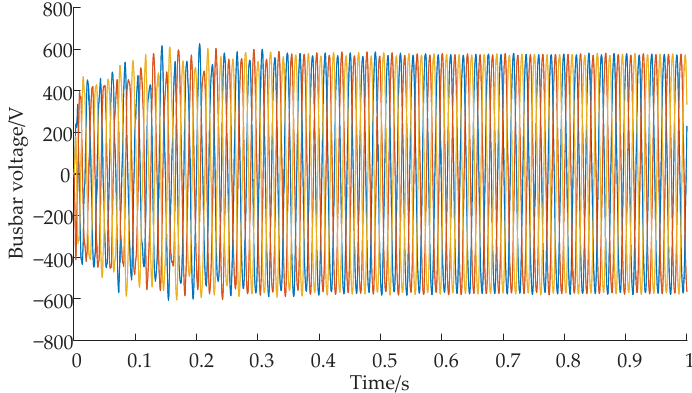
Figure 17. The bus voltage waveform when n 1 = 0.001 V/var and n 2 = 0.001 V/var.